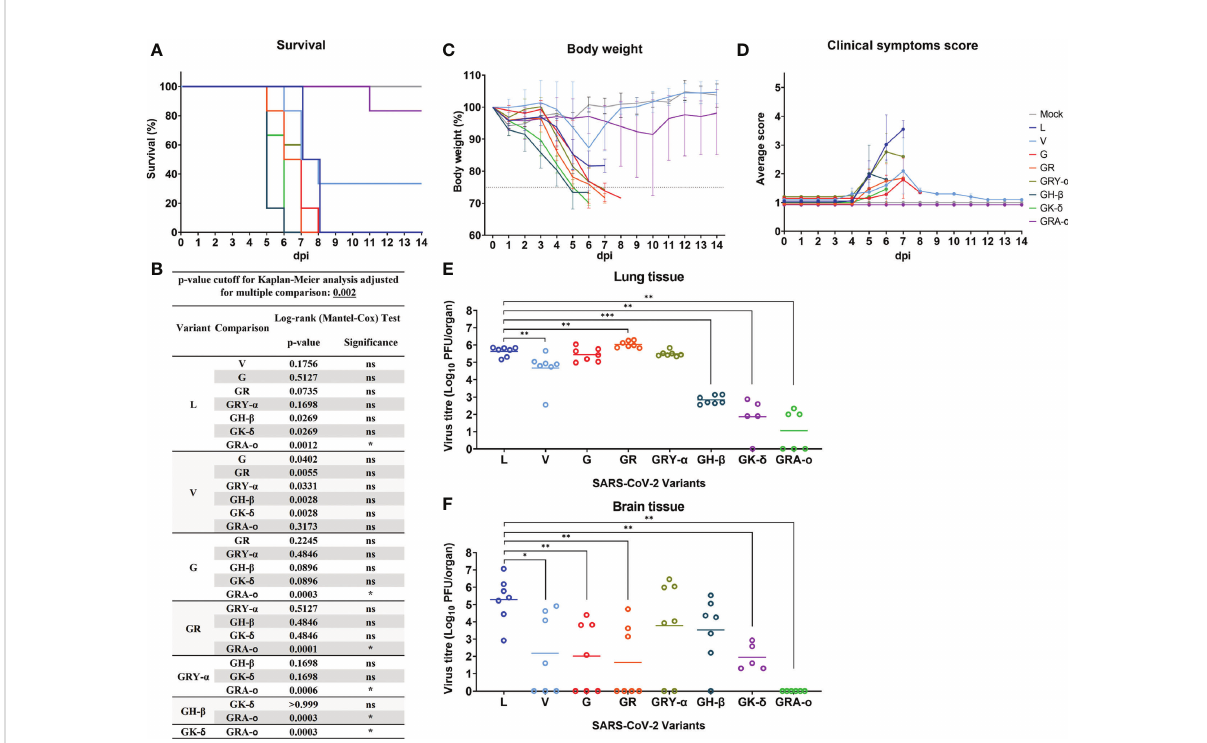
FIGURE 2 SARS-CoV-2 viruses infected K18-hACE2 transgenic mice. Physiological conditions and weight changes of infected mice group across different SARS-CoV-2 viruses (L, V, G, GR, GRY- a , GH- b , GK- d , and GRA-o), and uninfected mice over 14 dpi. Mice were infected with approximately 10 3 PFU of the respective SARS-2-CoV viruses through intranasal delivery. (A) Survival percentage of infected mice over 14 days, (B) Signi fi cance comparison of survival curves for SARS-CoV-2 infected mice. Comparison of signi fi cance between survival curves of various variant infected mice using log-rank (Mantel-Cox) test. Cut off for p-value using Kaplan-Meier analysis was adjusted to 0.002 for multiple comparison between various survival curves. (C) percentage changes in body weight, (D) changes in physiological condition quanti fi ed through scoring of clinical symptoms. Individual mouse was scored across 14 days from 1 (normal) to 5 (worst) for fi ve conditions: coat appearance, level of consciousness, activity, eye condition, and respiration. To determine clinical score of the infected mice, average of the fi ve physiological parameters for each infection group. All infection groups, n=6 with except of variant G, n=5, and mock infected mice, n=3. Error bars denotes range for each time point. (E, F) For viral load comparison after infection, mice were sacri fi ced at 4 dpi (L, V, G, GR, GRY- a , GH- b : n = 7 ; GK- d : n = 5 ; GRA-o: n = 6 ) with lungs, brain, liver, and spleen tissues harvested for titration. SARS-CoV-2 virus titre in lung and brain tissue determined via plaque assays. Geometric mean of viral titre is shown. Statistical signi fi cance between clade L and variants determined with two-tailed